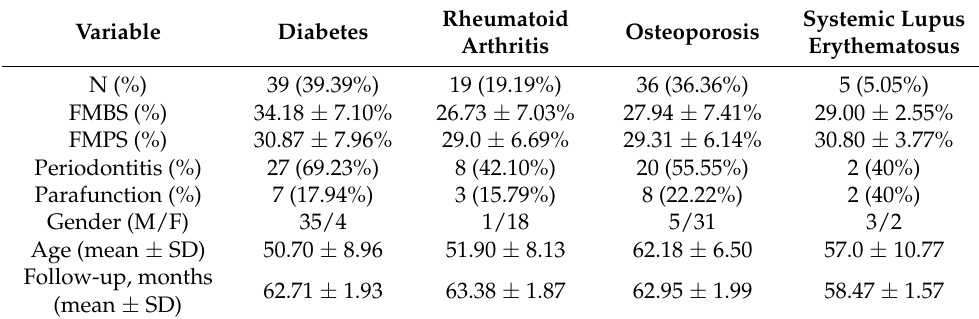
Table 1. Features of patients in the different groups.